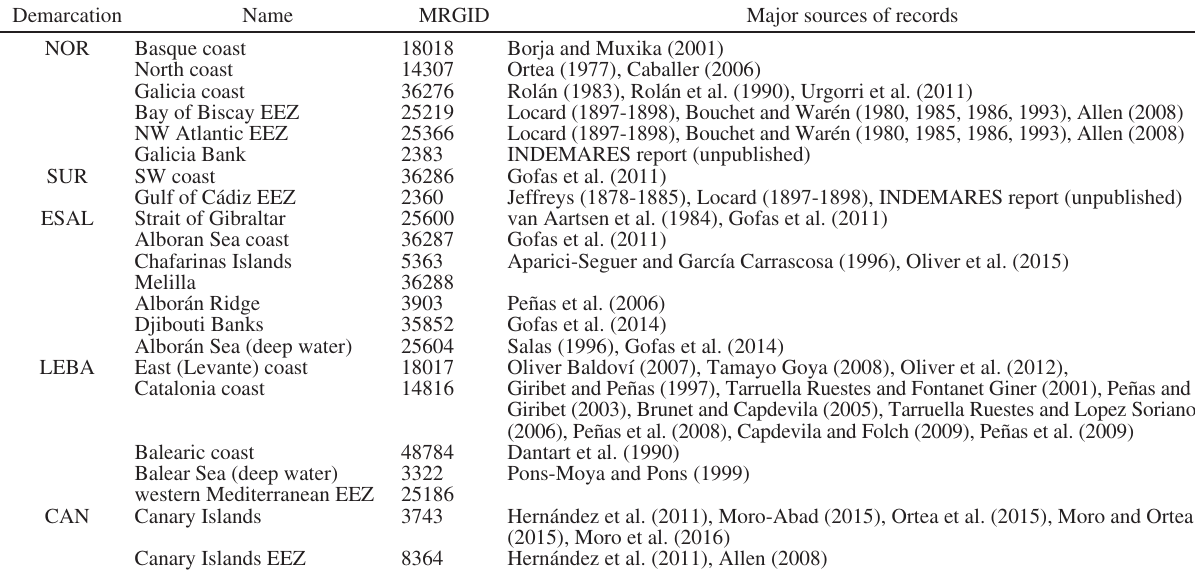
Table 1. – Geographic units used in establishing the list of marine mollusca in Spanish waters, with mention of the major sources used for each one. Minor sources are listed in WoRMS/MolluscaBase as a source for the distribution records. MRGID refers to the code of the geounits defined in the Marine Regions Gazetteer for the Spanish part of the mentioned areas.